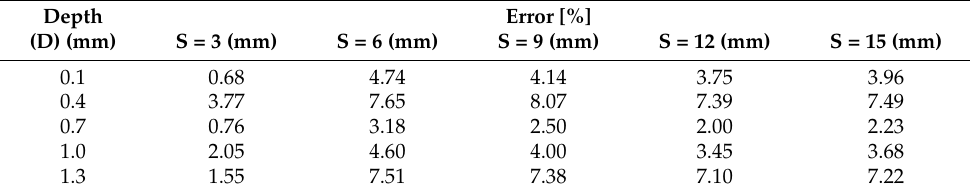
Table 6. Relative percent error (%) between estimated depth ( D e ) and actual depth ( D ) of defects for simulated thermal sequence maxigrams.